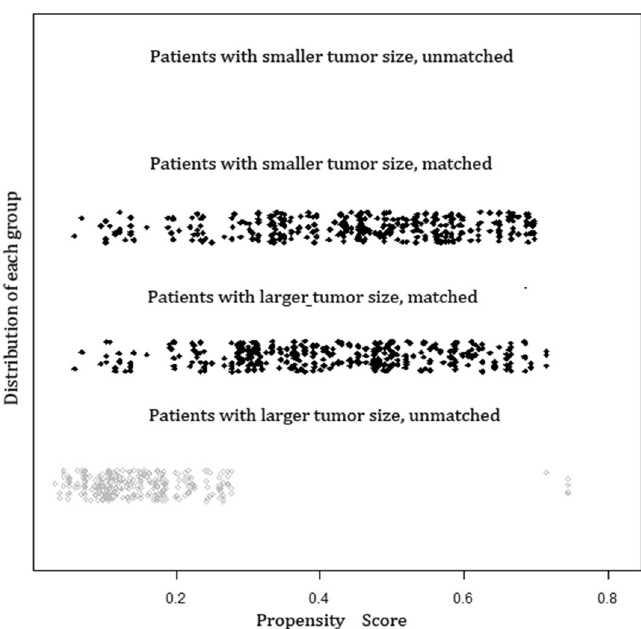
Figure 4. Distribution of the propensity scores. Each circle represents one